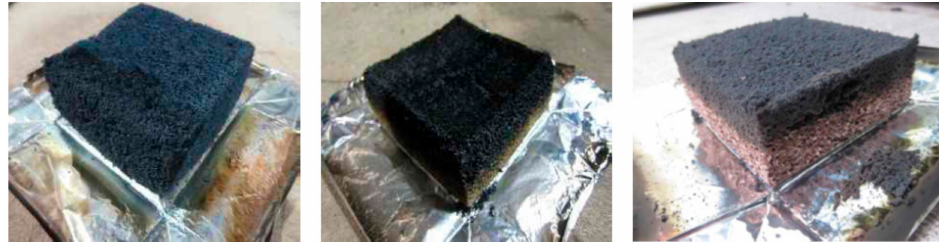
Figure 7. FR-EPS samples after the cone calorimeter